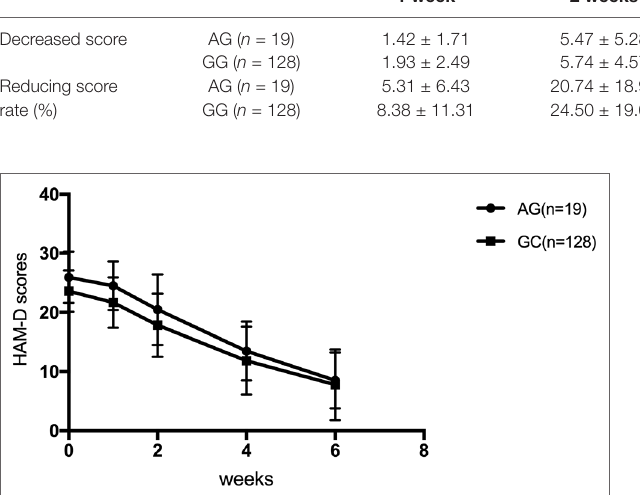
FIGURE 1 | Hamilton Rating Scale for Depression (HAM-D) scores at the first, second, fourth, and sixth